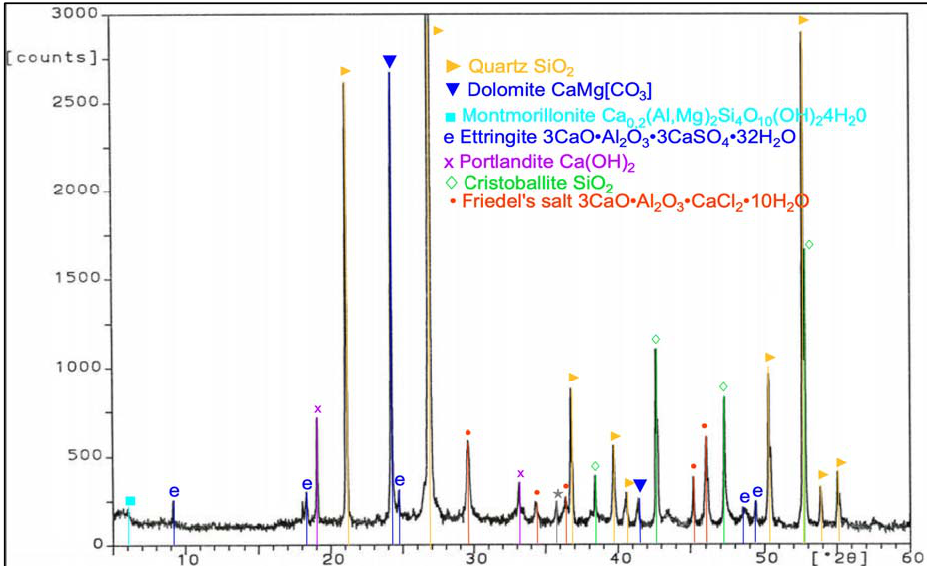
Figure 22. XRD pattern of the ZI mortar (100% CEM I) stored in 1% HCl for 730 days.